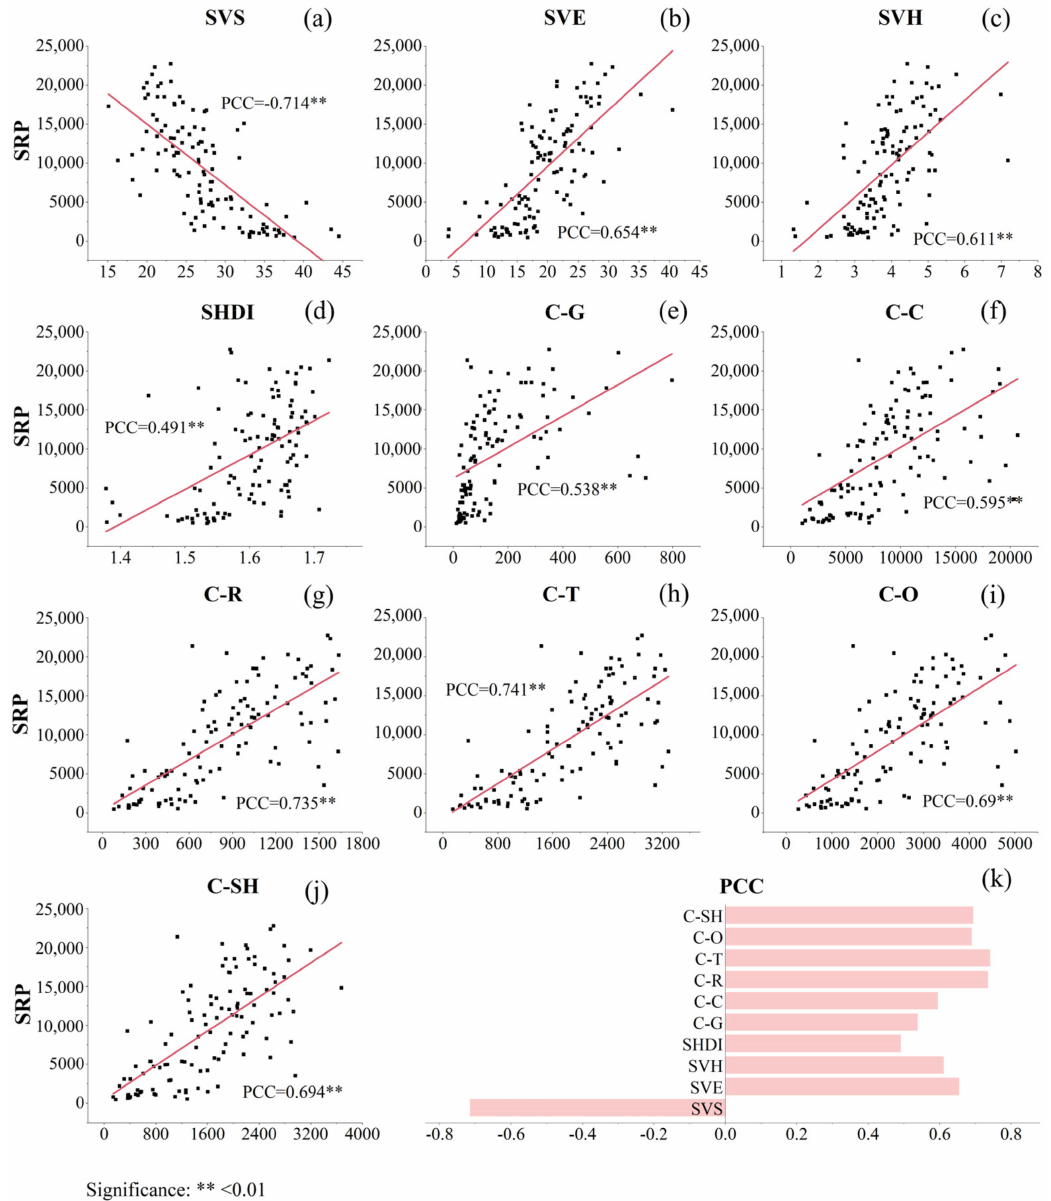
Figure 9. ( a – j ) Scatter diagram of human perception factors and the density of the settled population (DSP) ( k ) Pearson correlation coefficient (PCC) between human perception factors and the density of the settled population